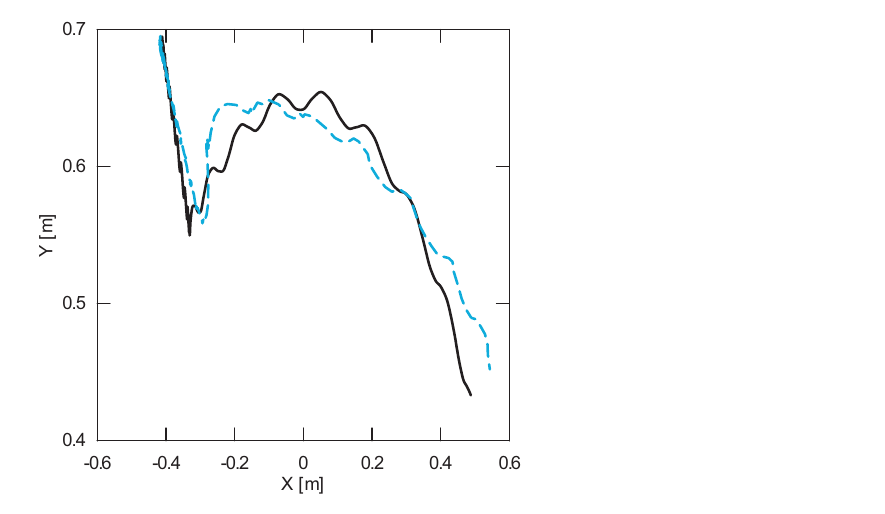
Figure 15. Projection of the trajectory of the transferred load in the rotation plane XY (solid line— numerical calculations; dashed line—experiment results).